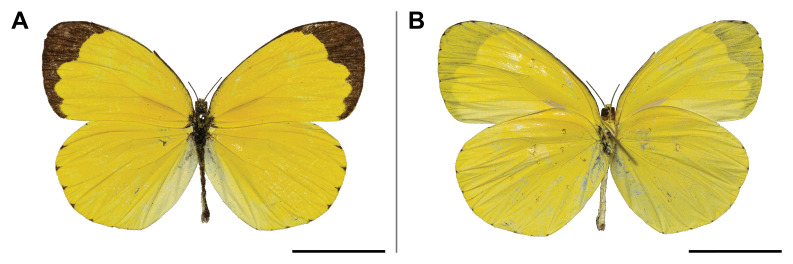
Eurema
floricola
leonis (Butler, 1886). A. dorsal view; B. ventral view. The scale bar represents 1 cm.